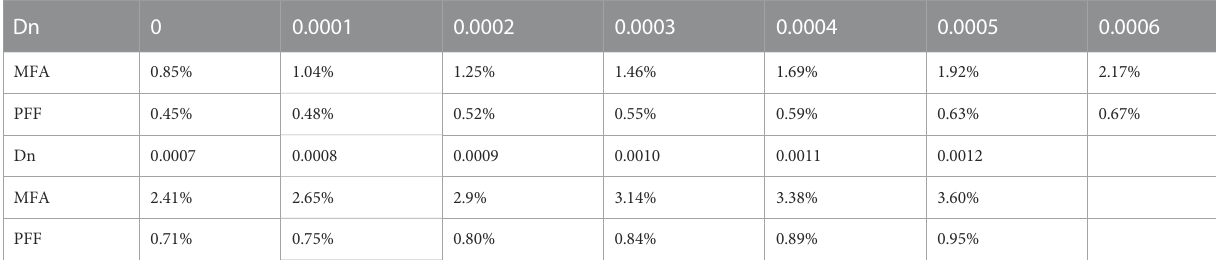
TABLE 1 DF under different dip